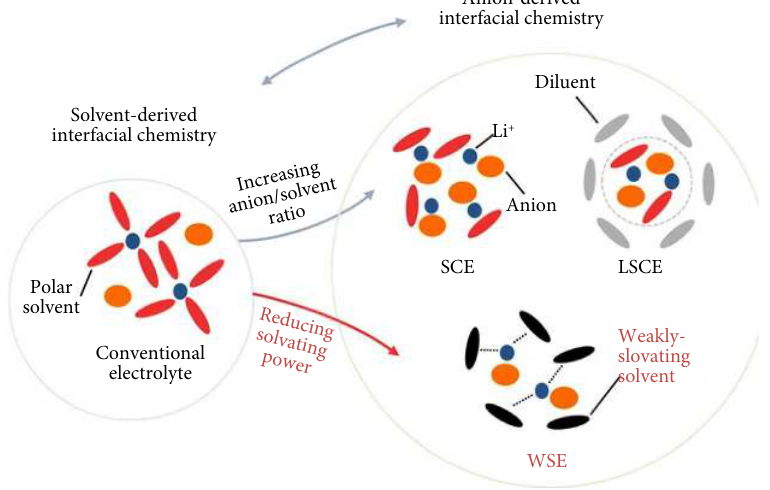
Fig. 5 The solvation structures of Li ions and corresponding interfacial chemistry in various electrolytes. SCE: superconcentrated electrolyte, LSCE: localized superconcentrated electrolyte, WSE: weakly solvating electrolyte (reprinted with permission from Ref. [78], © 2020